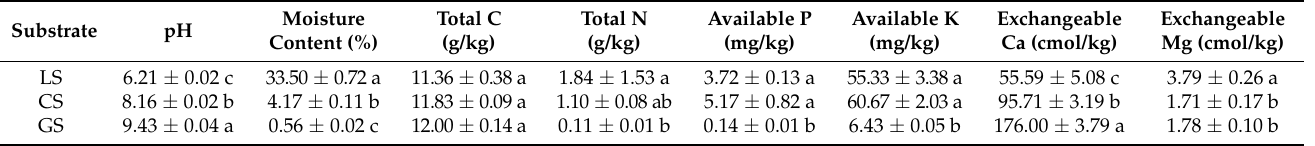
Table 1. Basic physicochemical characteristics of three growth